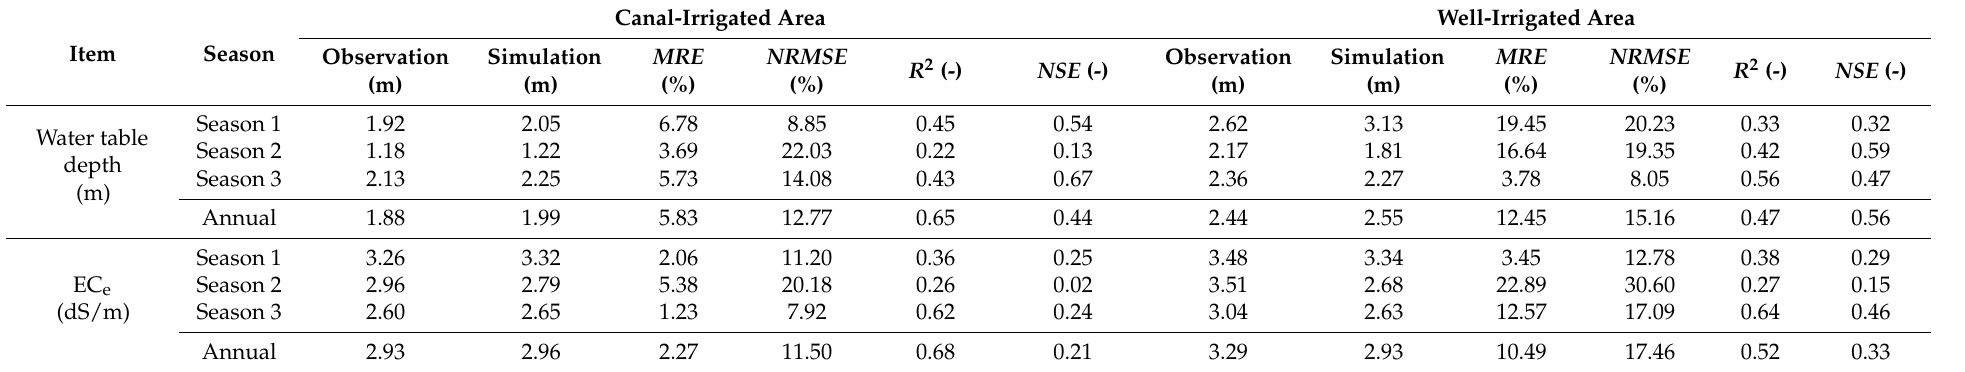
Table 6. Model validation results by comparing the simulated and measured water table depths and root zone soil salinities.